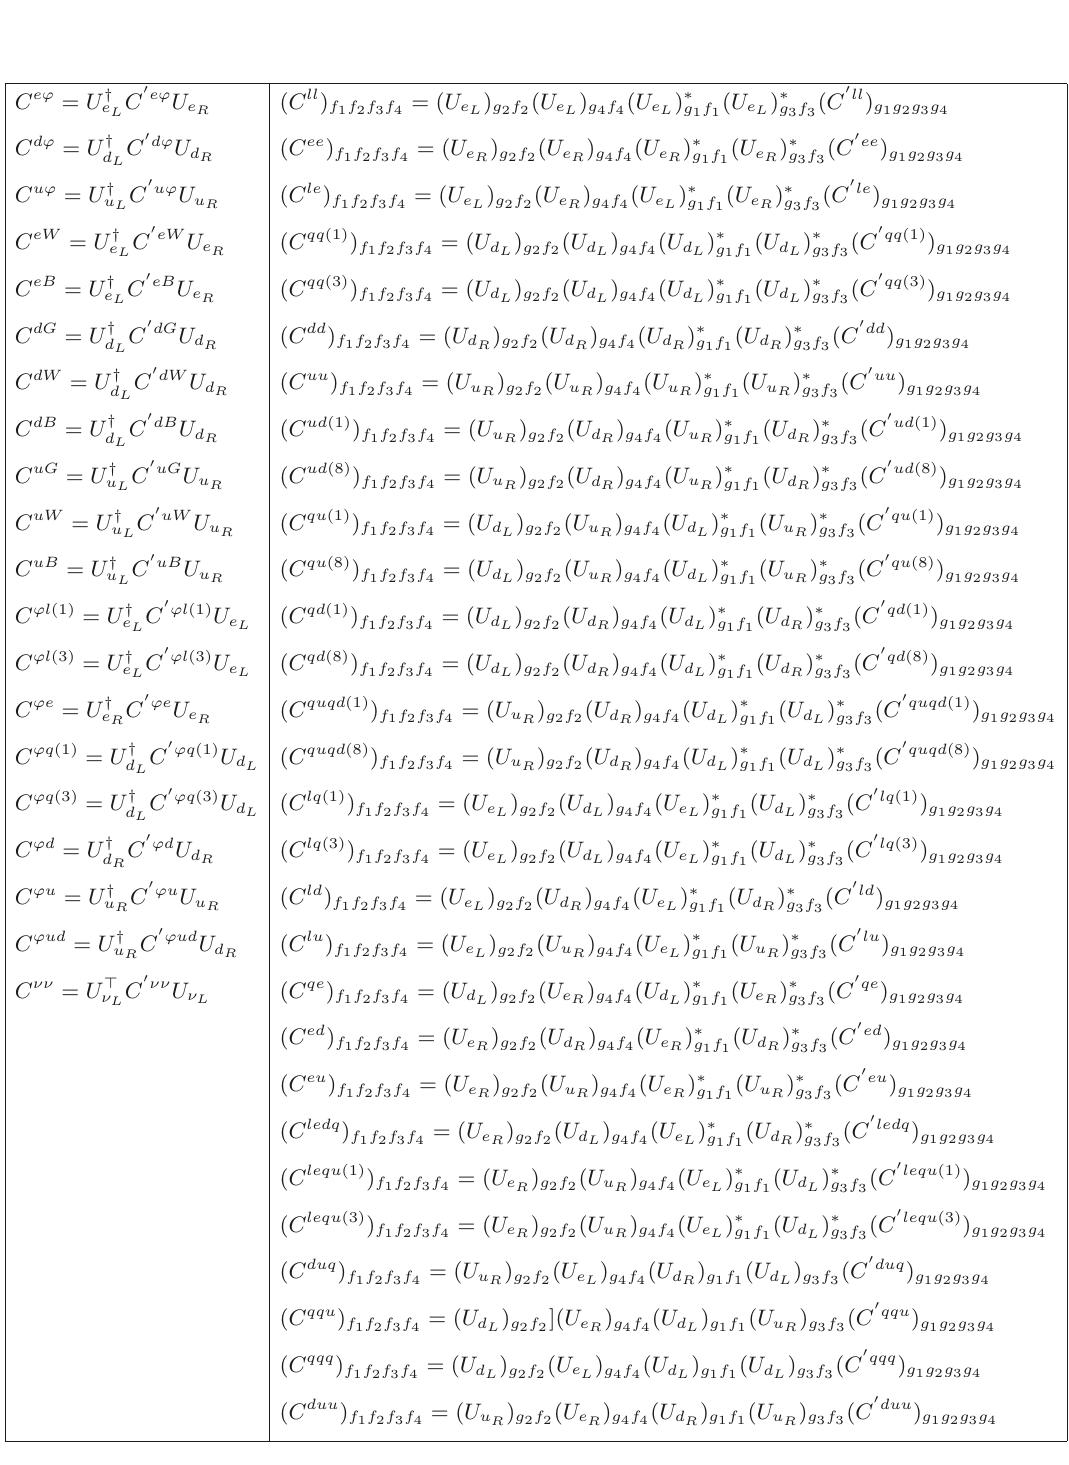
Table 4 . Definitions of the Wilson coefficients multiplying the fermionic currents in the mass